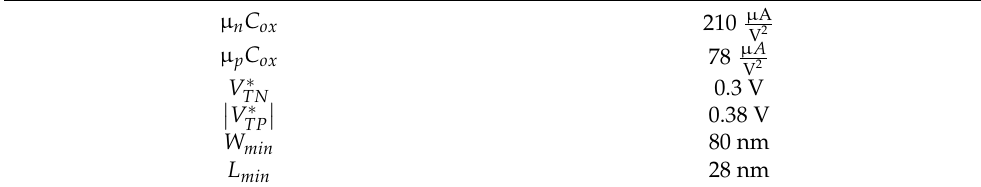
Table 2. The 28 nm FD-SOI CMOS technology: main process